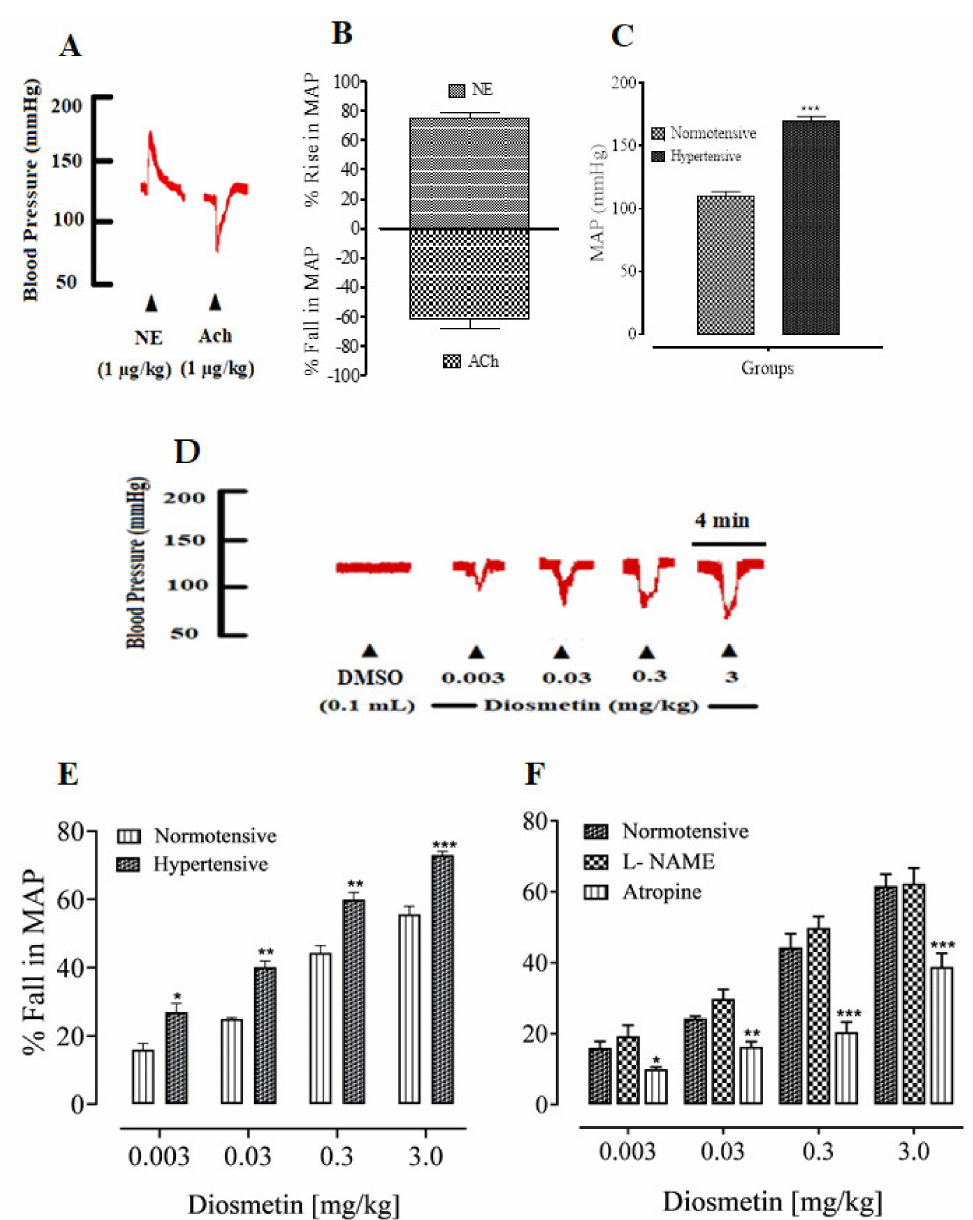
Figure 2. A representative tracing ( A ) showing the effects of norepinephrine (NE) and acetylcholine (Ach) on the mean arterial pressure (MAP): ( B ) the percentage increases and decreases in the BP of anesthetized normotensive rats; ( C ) the significant changes ( p < 0.001) in the MAP of normotensive anesthetized rats; ( D ) A representative tracings of invasive blood pressure (BP) measurement tracings show the fall in blood pressure by the diosmetin in normotensive rats; ( E ) a comparison of the percentage decreases in the mean arterial pressure (MAP) of normotensive and hypertensive rats that were caused by diosmetin; ( F ) the effects of pretreatment with 20 mg/kg of L-NAME and 1 mg/kg of atropine in normotensive rats. Significant differences ( n = 6): * p < 0.05; ** p < 0.01; *** p <